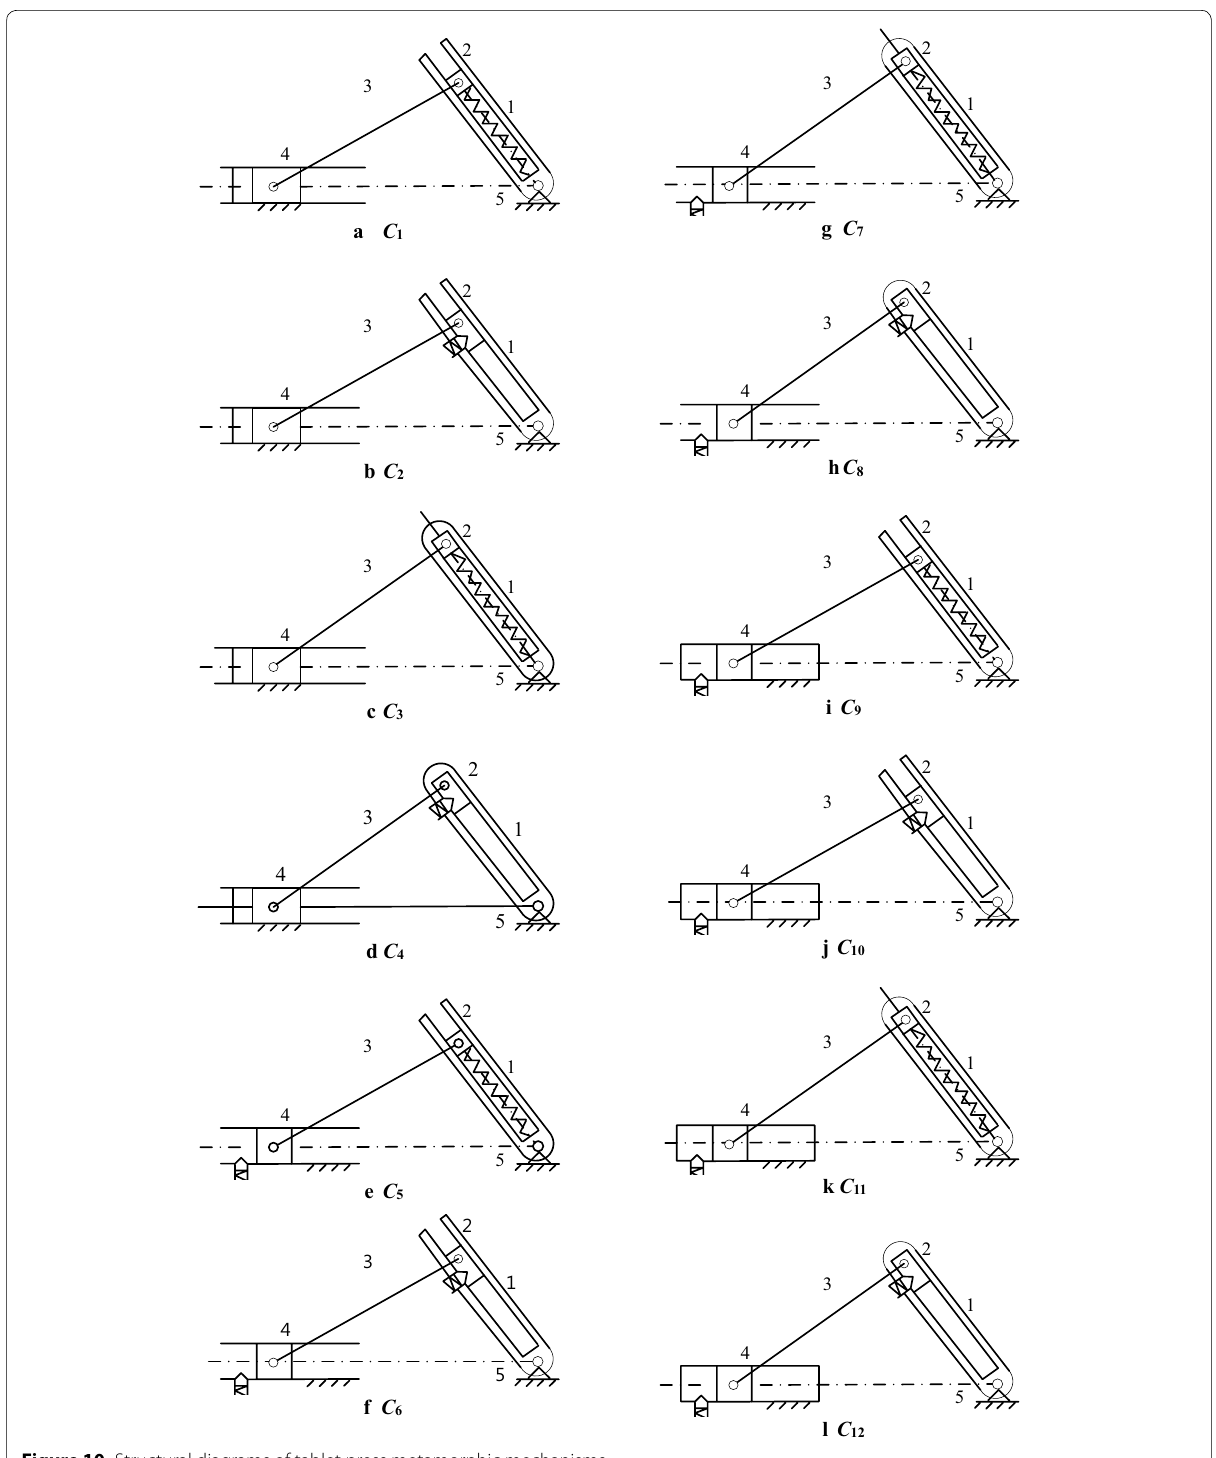
Figure 10 Structural diagrams of tablet press metamorphic